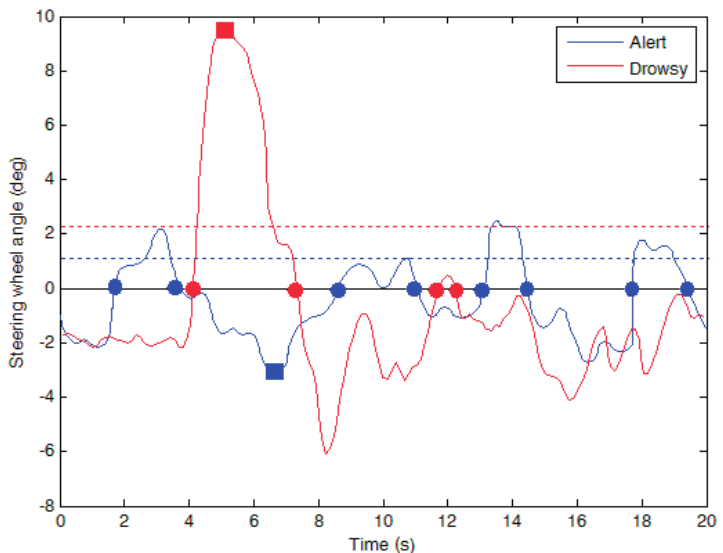
Figure 6. A sample of steering angle variations in a 20 s